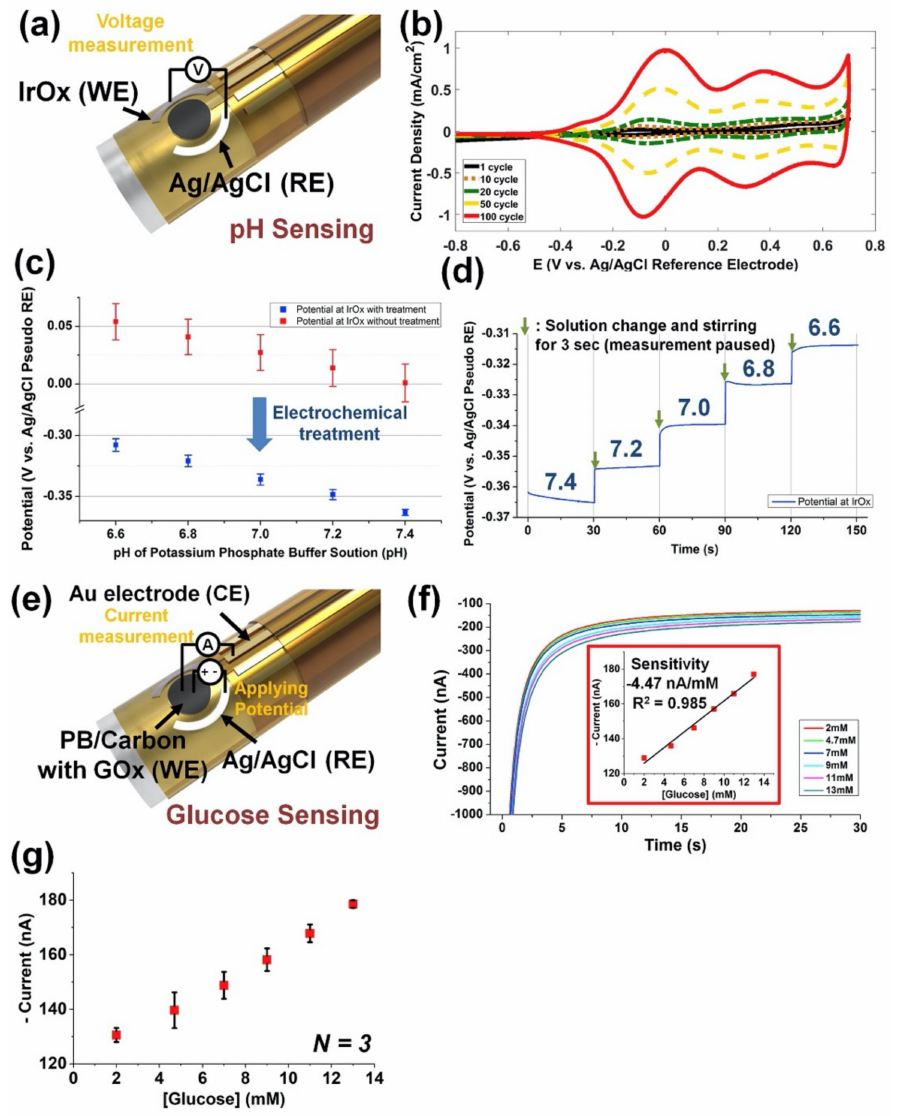
Figure 11. ( a ) The measurements principles of the iridium oxide-based pH sensor. ( b ) Cyclic Voltammetry plot of the electrodeposition of iridium oxide with the precursor electrolyte. ( c ) the pH responses before and after electrochemical treatment. ( d ) the pH response of the constructed iridium oxide sensor. ( e ) the glucose sensor configuration. ( f ) the amperometric glucose sensing performance. ( g ) the linear range of the glucose measurement for three replicates. Reprinted with permission from reference [56]. Copyright 2019 Elsevier